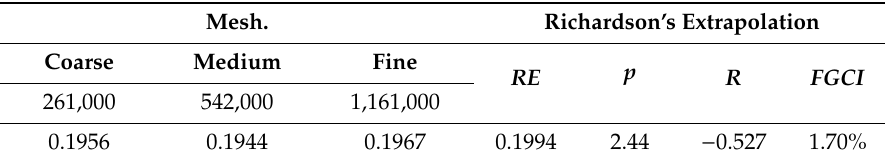
Table 1. Mesh size dependence